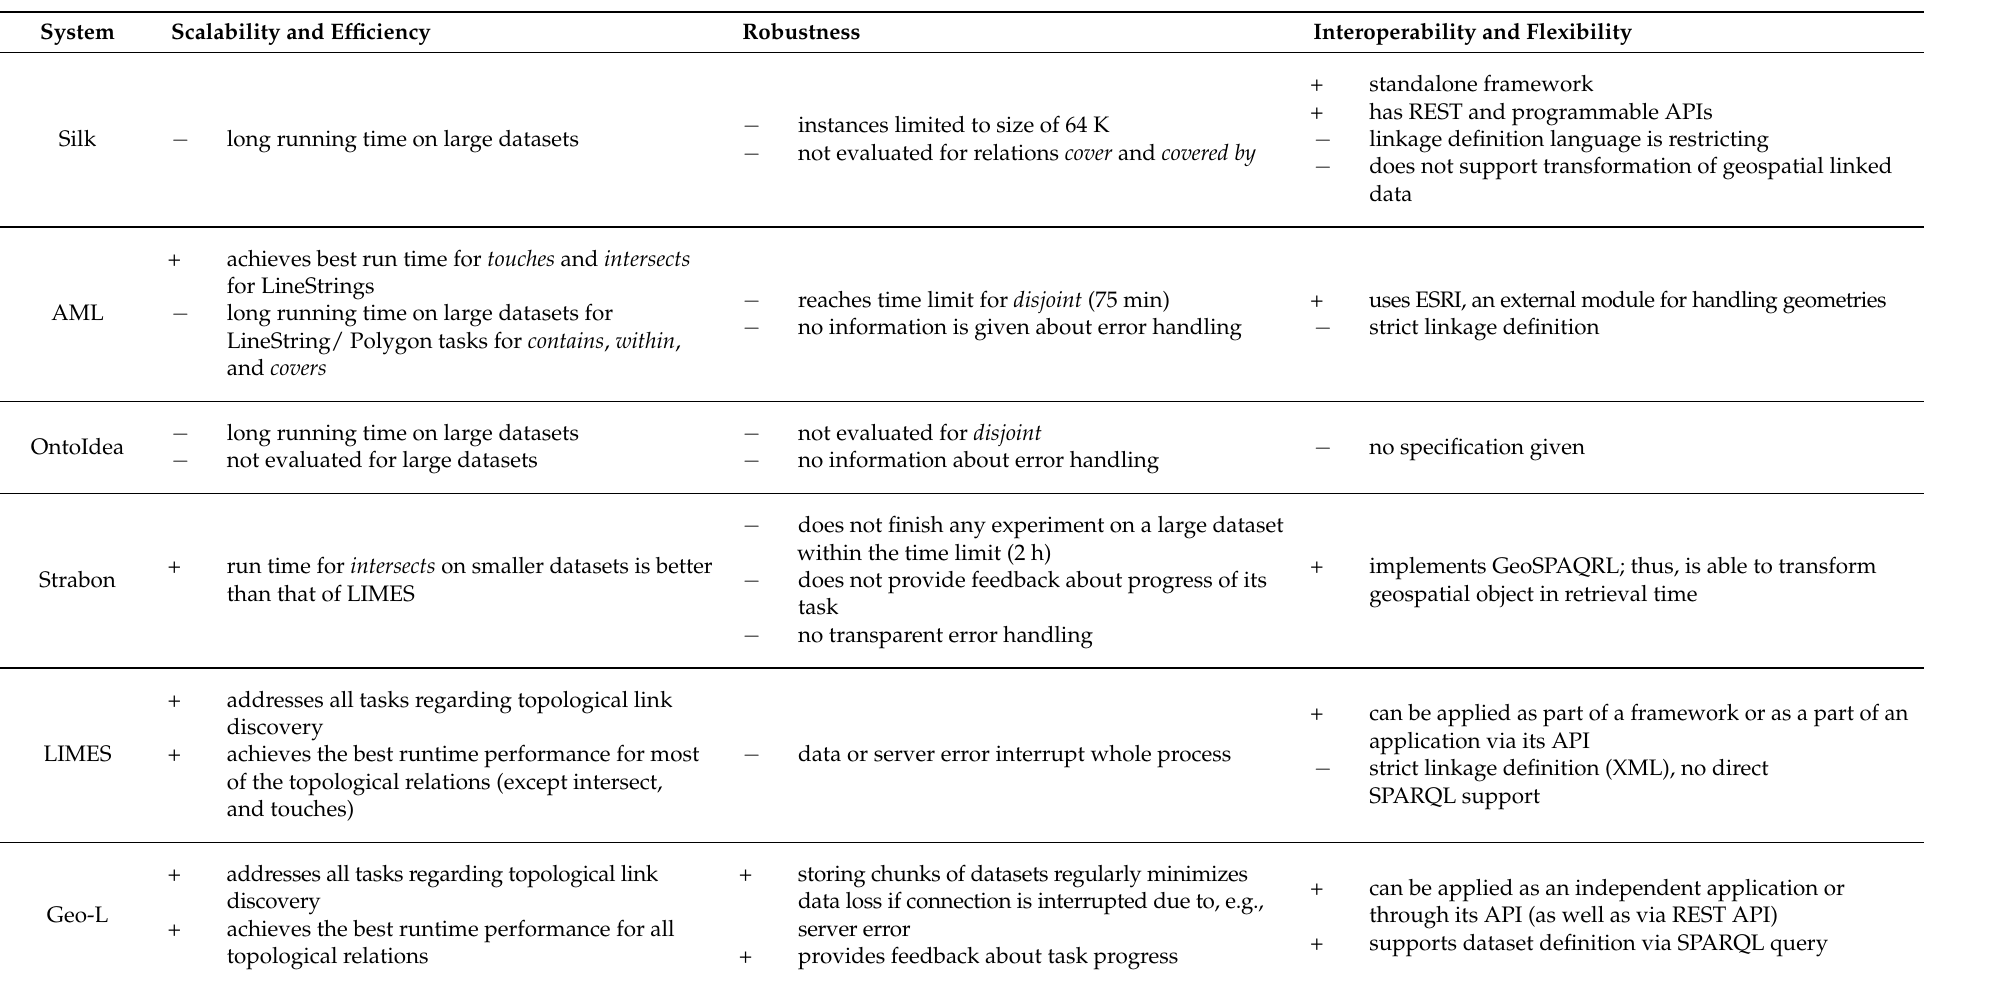
Table 2. Comparison of properties of systems for topological link